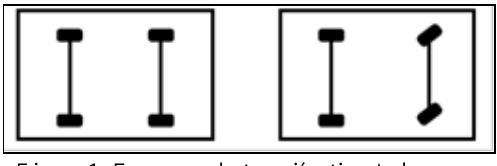
Figura 1: Esquema de tracción tipo Ackerman. Fuente: Los autores, (2018).